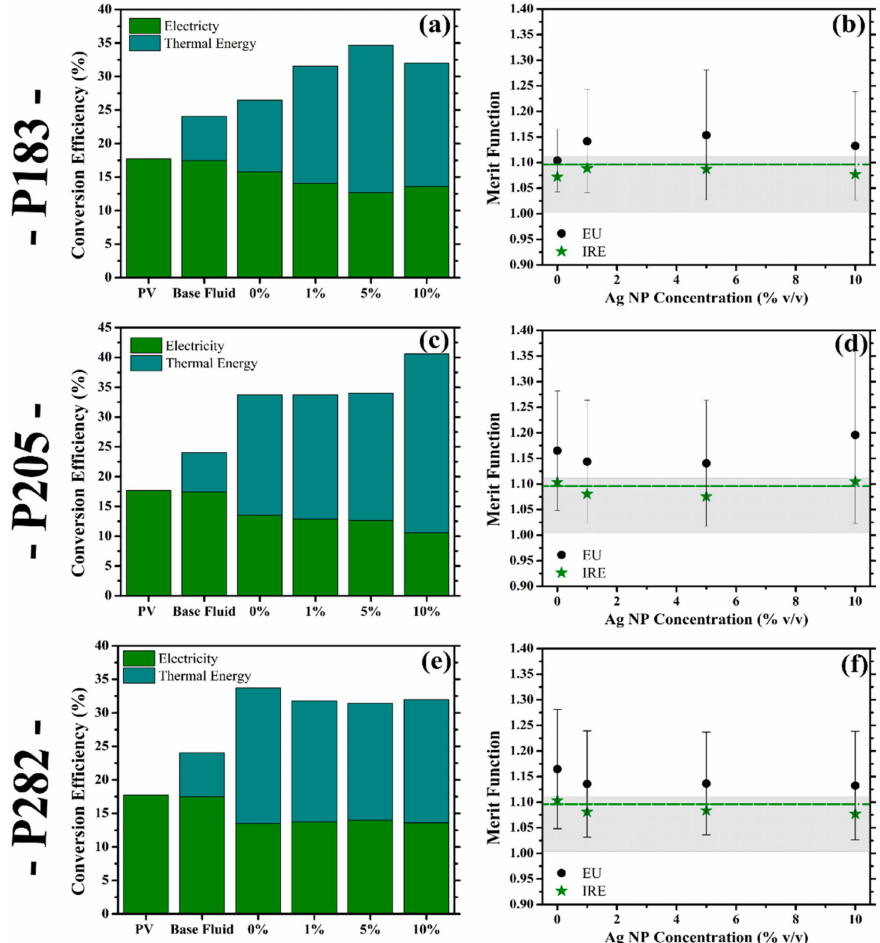
Figure 5. The combined conversion e ffi ciency (%) of the spectral beam-splitting photovoltaic-thermal (SBS-PVT) system in response to the filtered spectral behaviour provided by the ( a ) P183, ( c ) P205, and ( e ) P282 PLDS nanolfuids. The changes in the performances of the individual electrical and thermal performances can also be observed. The electrical power of the unfiltered PV system is provided for comparison. The merit function of a C-PVT system incorporating mc-Si solar cells for each PLDS nanofluid filter (( b )—P183, ( d )—P205, ( f )—P282) according to the average worth factor derived across the European (EU—black circle) region, with the Republic of Ireland (IRE—geen star) economy being added for comparison. The filled region (light grey) and dashed line (green) represents the performance of the base fluid under the European conditions and the Republic of Ireland,